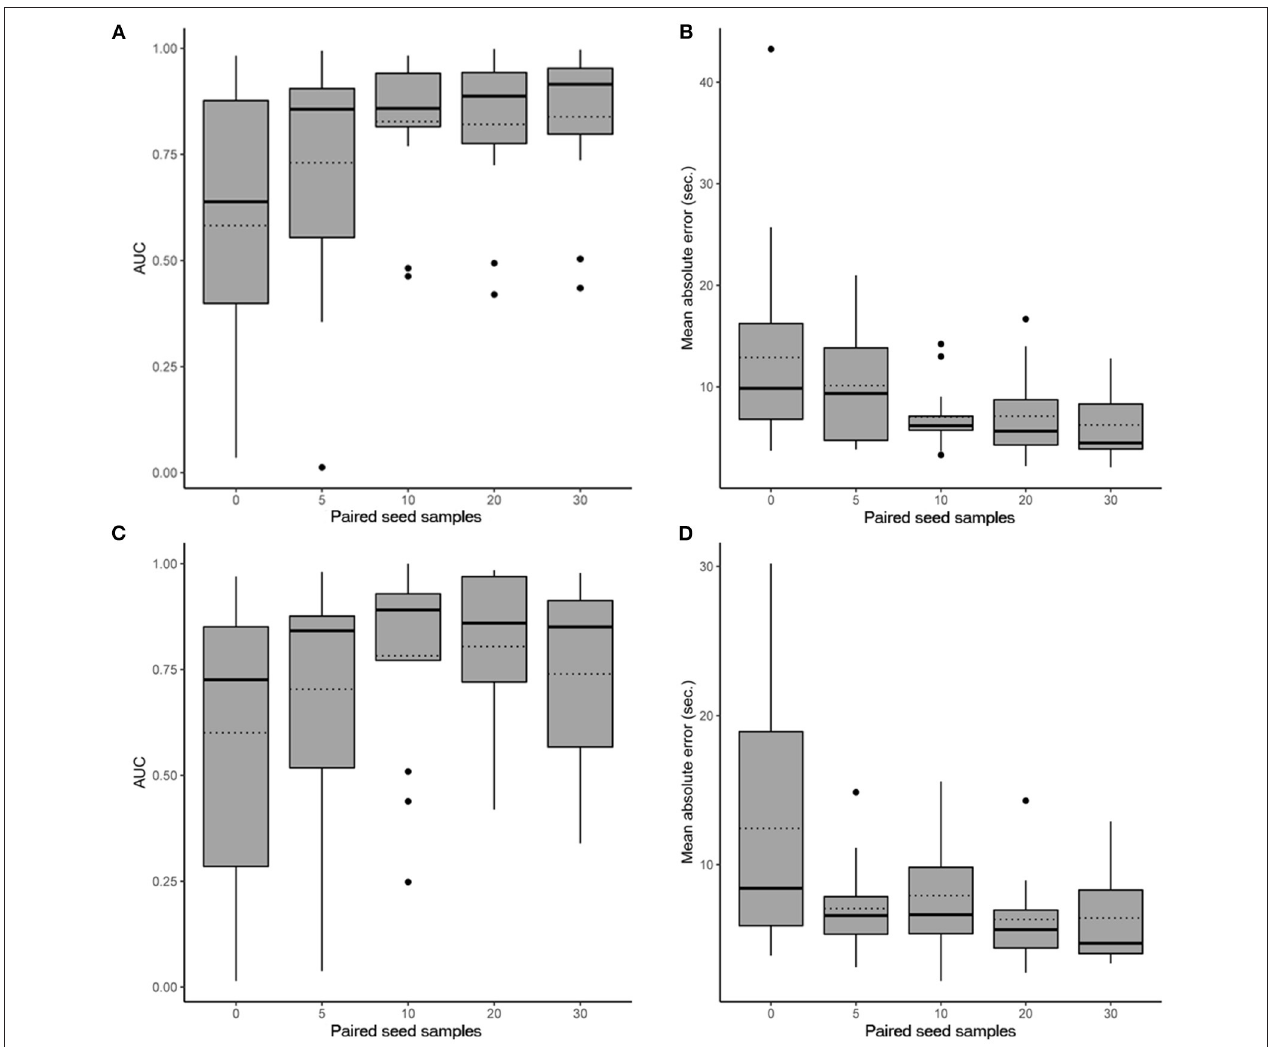
FIGURE 2 | Performance evaluation of the CNN. Box plots show the 25th and 75th percentiles, median (solid), mean (dotted), minimum, and maximum values with outliers shown as dots. (A) AUPRC results (accounting for all past patients) for different numbers of paired seed data for our CNN in scenario 1 when detecting iEEG ictal patterns vs. non-ictal patterns. (B) Absolute mean regression error results for our CNN in scenario 1. (C) AUPRC results (accounting for all past patients) for different numbers of paired seed data for our CNN in scenario 2 when detecting iEEG ictal patterns vs. non-ictal patterns. (D) Absolute mean regression error results for our CNN in scenario